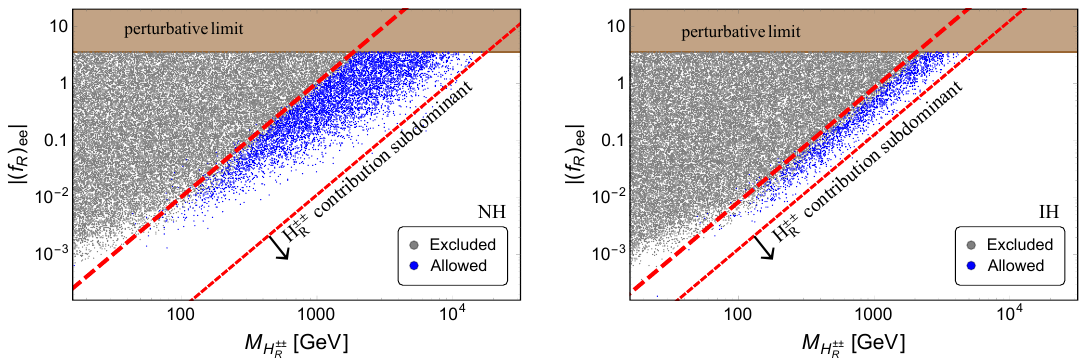
Figure 18 . 0 (cid:23)(cid:12)(cid:12) constraints on H (cid:6)(cid:6) mass and its Yukawa coupling to electrons j ( f R ) ee j for the R neutrino spectra of NH (left) and IH (right). All the gray points are excluded by the KamLAND- Zen [134] and GERDA [135] limits, while those in blue are allowed. The brown bands are excluded p by the perturbativity requirement of j ( f R ) ee j < 4 (cid:25) . Below the short-dashed red lines, the H (cid:6)(cid:6) R contribution to 0 (cid:23)(cid:12)(cid:12) is sub-dominant to other terms in eq. (3.6).